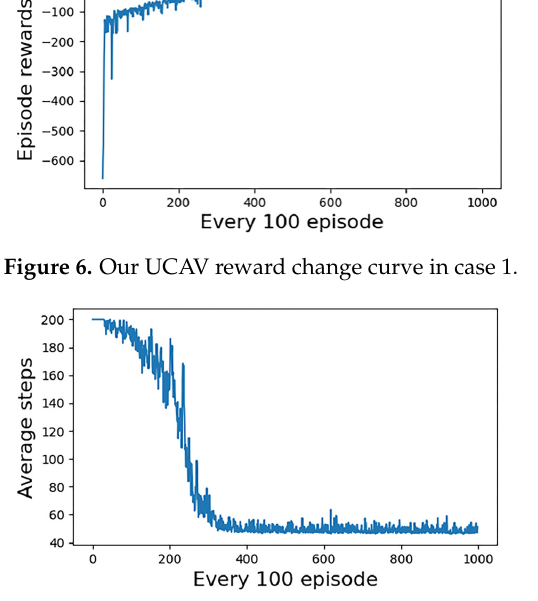
Figure 7. The change curve of turn steps in case